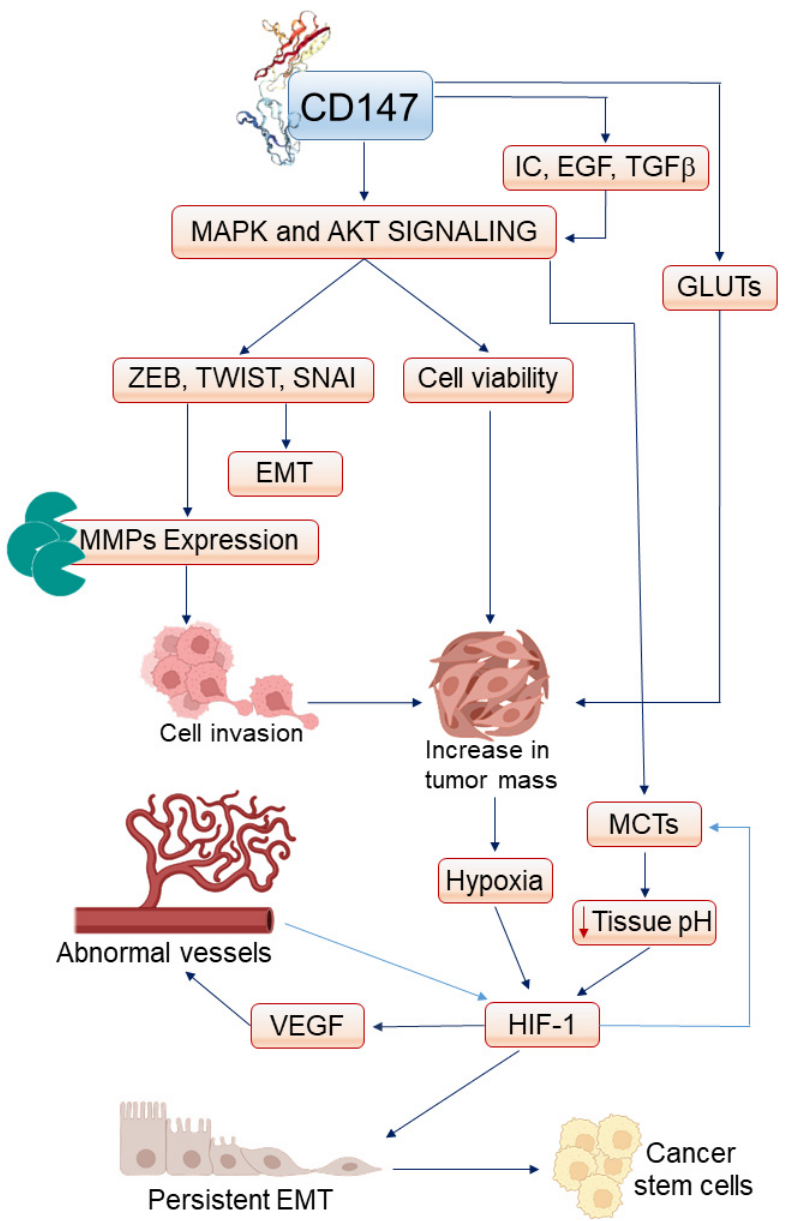
Figure 2. CD147 affects OSCC development and progression by modulating epithelial cell viability, growth, motility, and differentiation. Arrows symbolize directions of connections. Abbreviations: